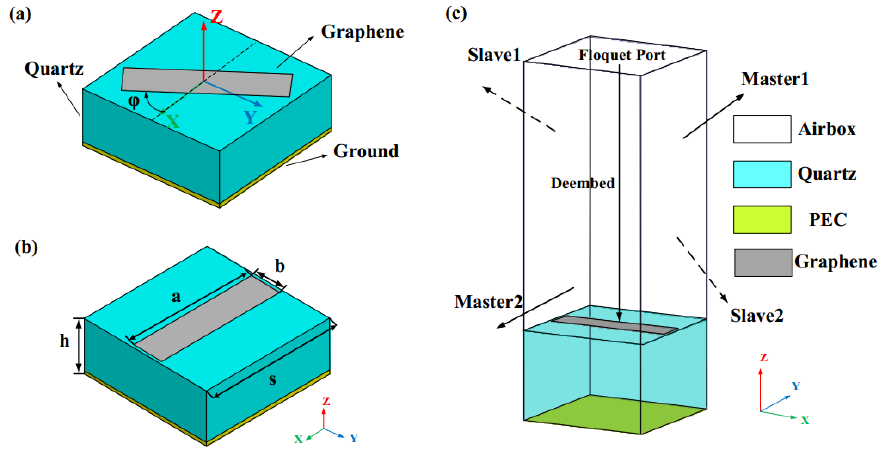
Figure 3. Illustration of the proposed graphene meta-atom: ( a ) Structure of the graphene element when it is rotated at an orientation angle ϕ with respect to the x -axis; ( b ) the parameters of the graphene element; ( c ) simulation setup.